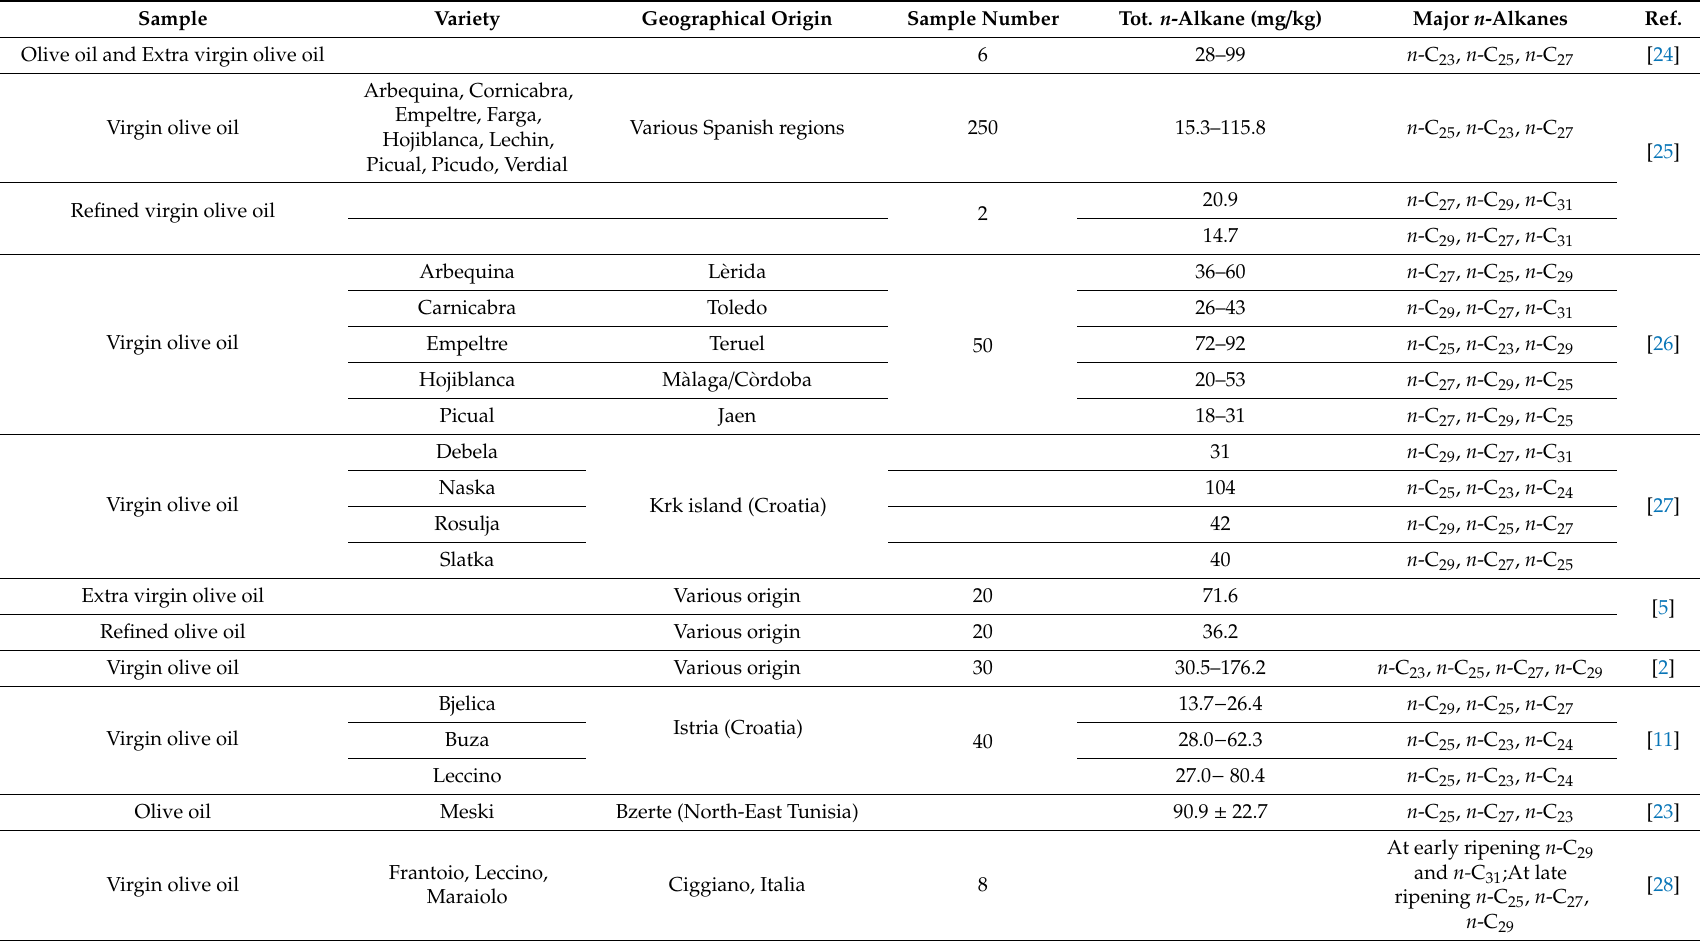
Table 1. Summary of n-alkanes presence in extra virgin olive oils, olive oils and refined olive